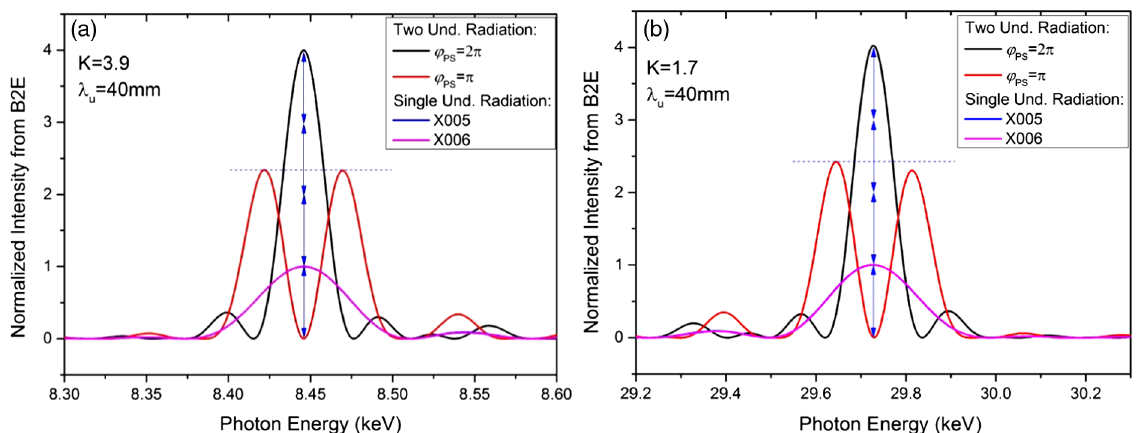
FIG. 13. On-axis spectrum calculated with B2E from measured magnet data of the undulators U40-X005 and U40-X006 and the phase shifter PS073. (a) K ¼ 3 . 9 ; (b) K ¼ 1 . 7 ; black curves correspond matched phase φ φ π . The same relative scale applies to all curves. Single undulator spectra coincide within linewidths. Only the spectrum of the PS ¼ U40-X006 is shown, that of the U40-X005 is